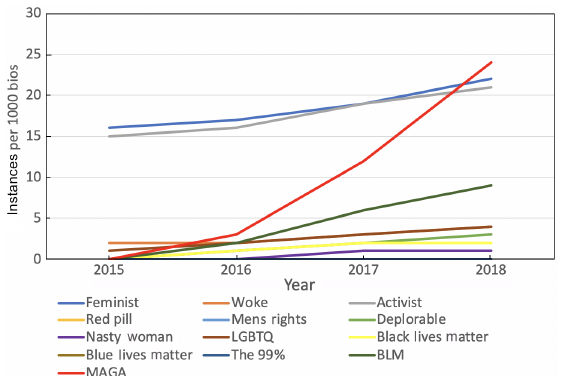
Fig. 6 Prevalence of “implicit polities” bio keywords, by year—cross-sectional